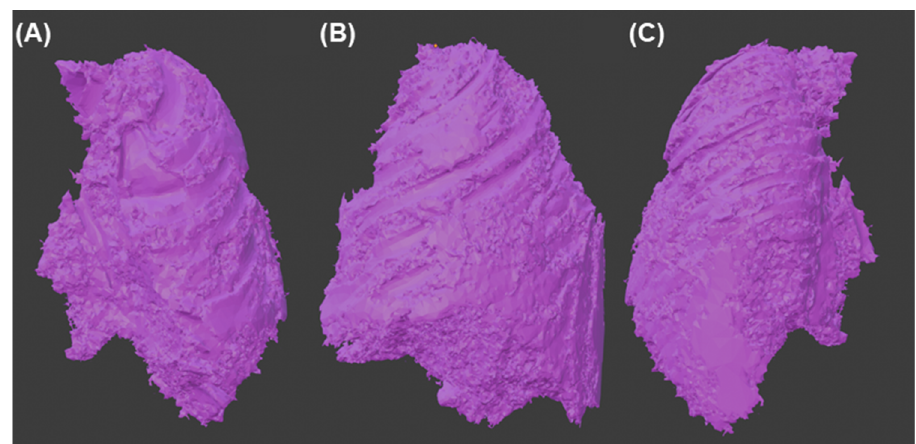
Figure 9. Final 3d model of the tumor ( A ) Front view ( B ) Side view ( C ) Back view.